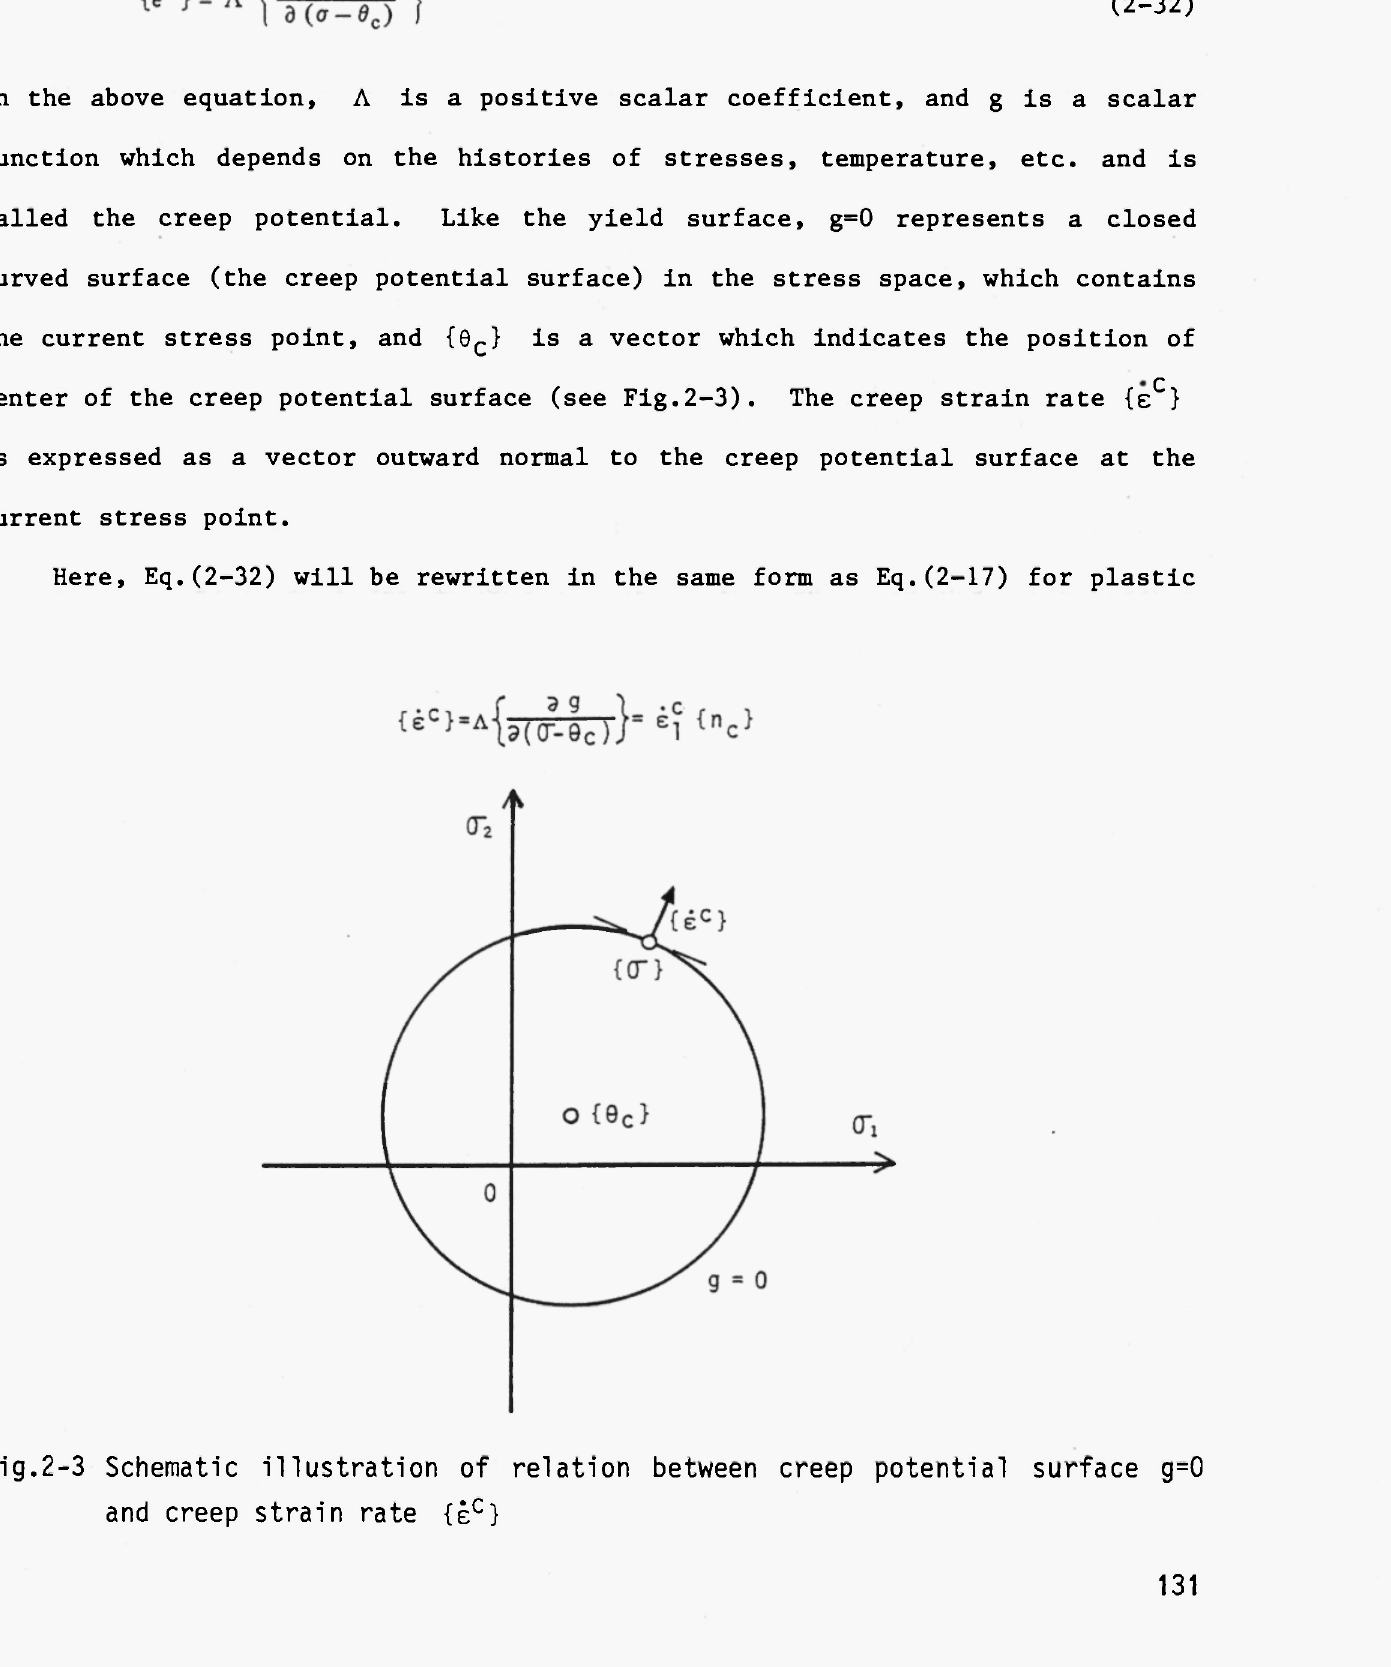
Fig.2-3 Schematic illustration of relation between creep potential surface g=0 and creep strain rate {έ°}